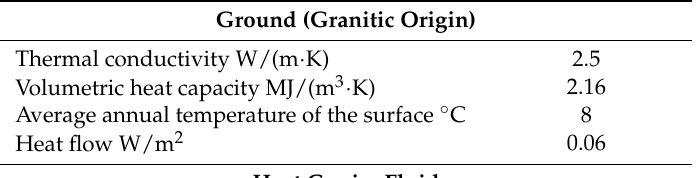
Table 5. Input data used in the calculation with the software “Earth Energy Designer”.